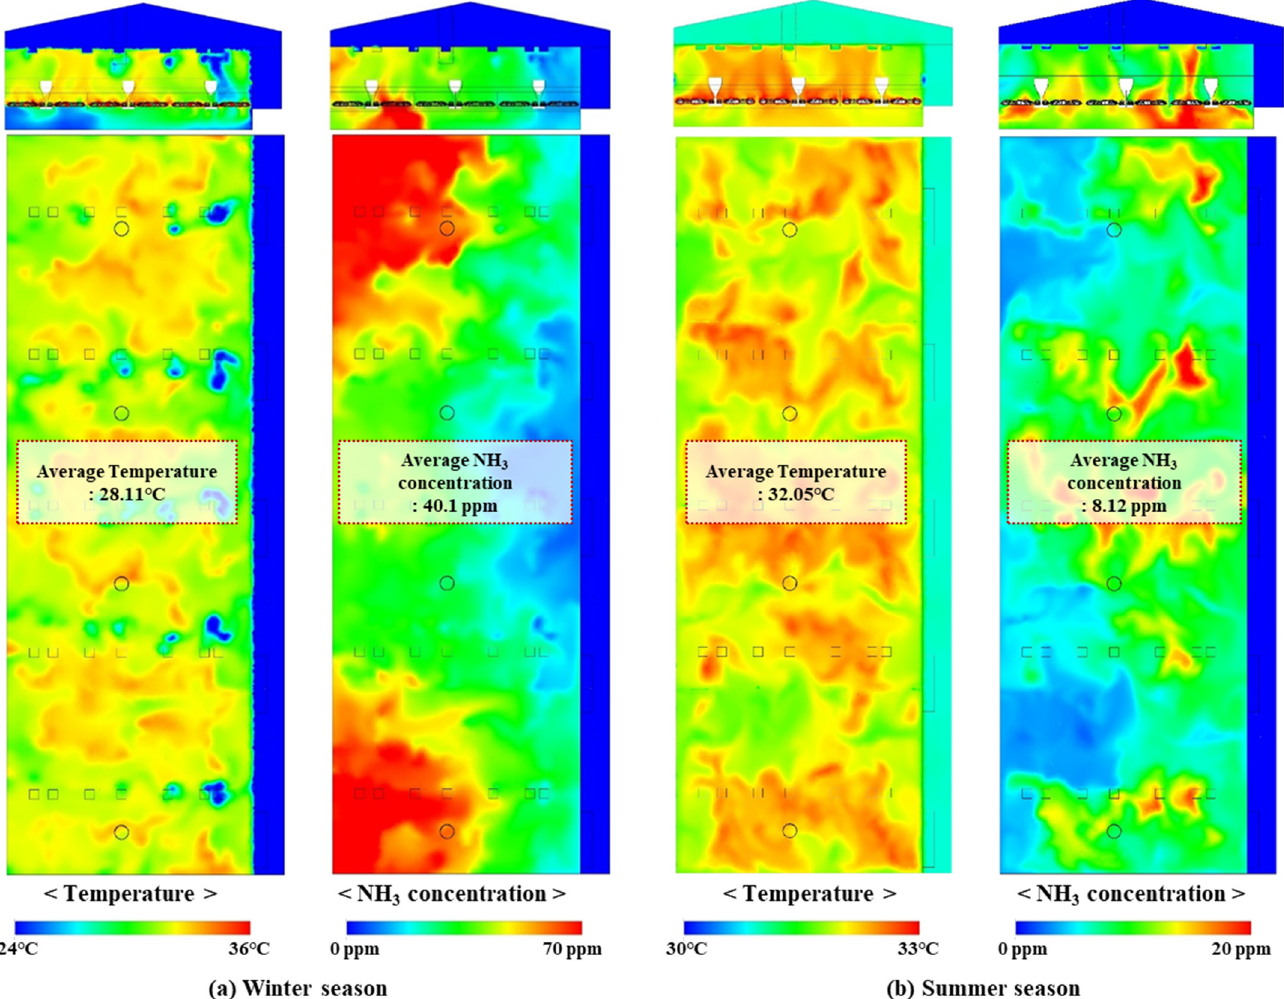
Figure 14. CFD computed results of visualization of the internal air temperature and ammonia concentration contour of the experimental piglet house in winter and summer .